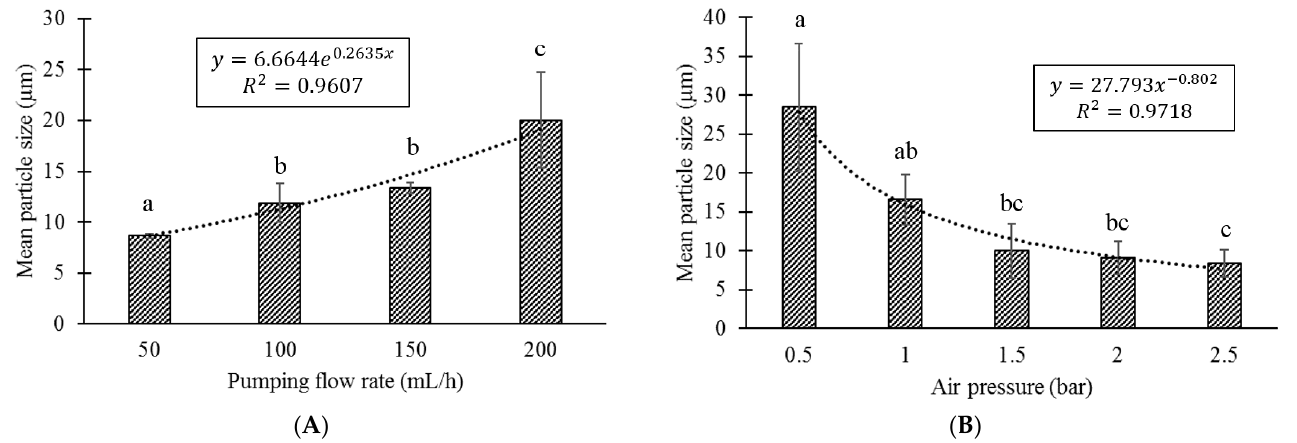
Figure 2. The influence of pumping flow rate ( A ) or air pressure ( B ) of the aerodynamically assisted jetting (AAJ) system on the mean particle size of the microparticles obtained. Working conditions of the AAJ were: alginate concentration: 3% w / v ; CaCl 2 concentration: 0.25 M; distance: 25 cm; flow rate: 100 mL/h ( A ); air pressure: 1.5 bar ( B ). Different lowercase letters indicate significant differences ( p ≤ 0.05) of the mean particle size among the different pumping flow rates or air pressures evaluated.